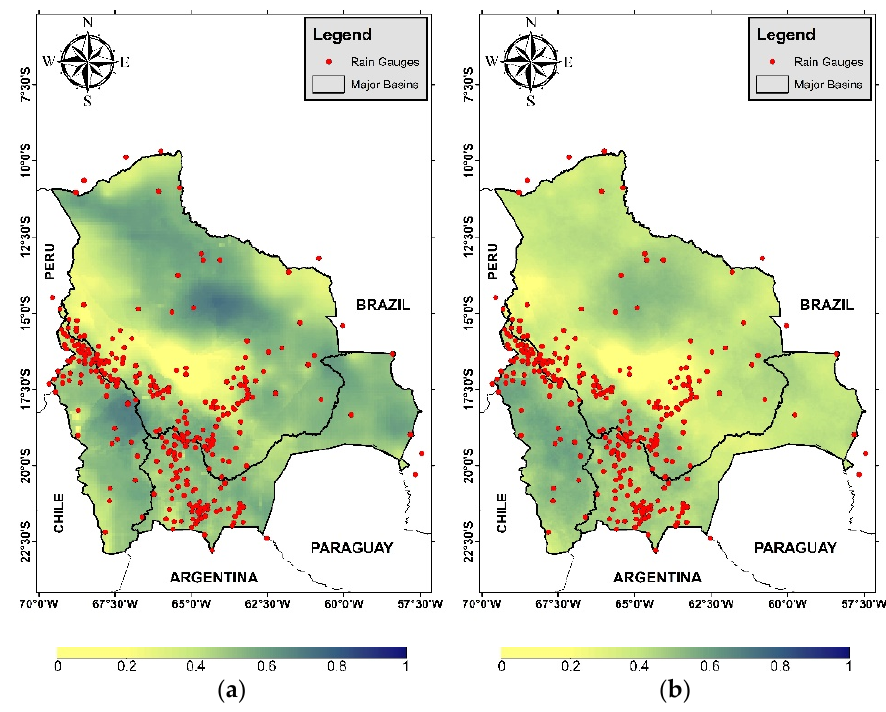
Figure 9. Daily correlation coefficient map: ( a ) GSMaP and ( b ) CHIRPS.